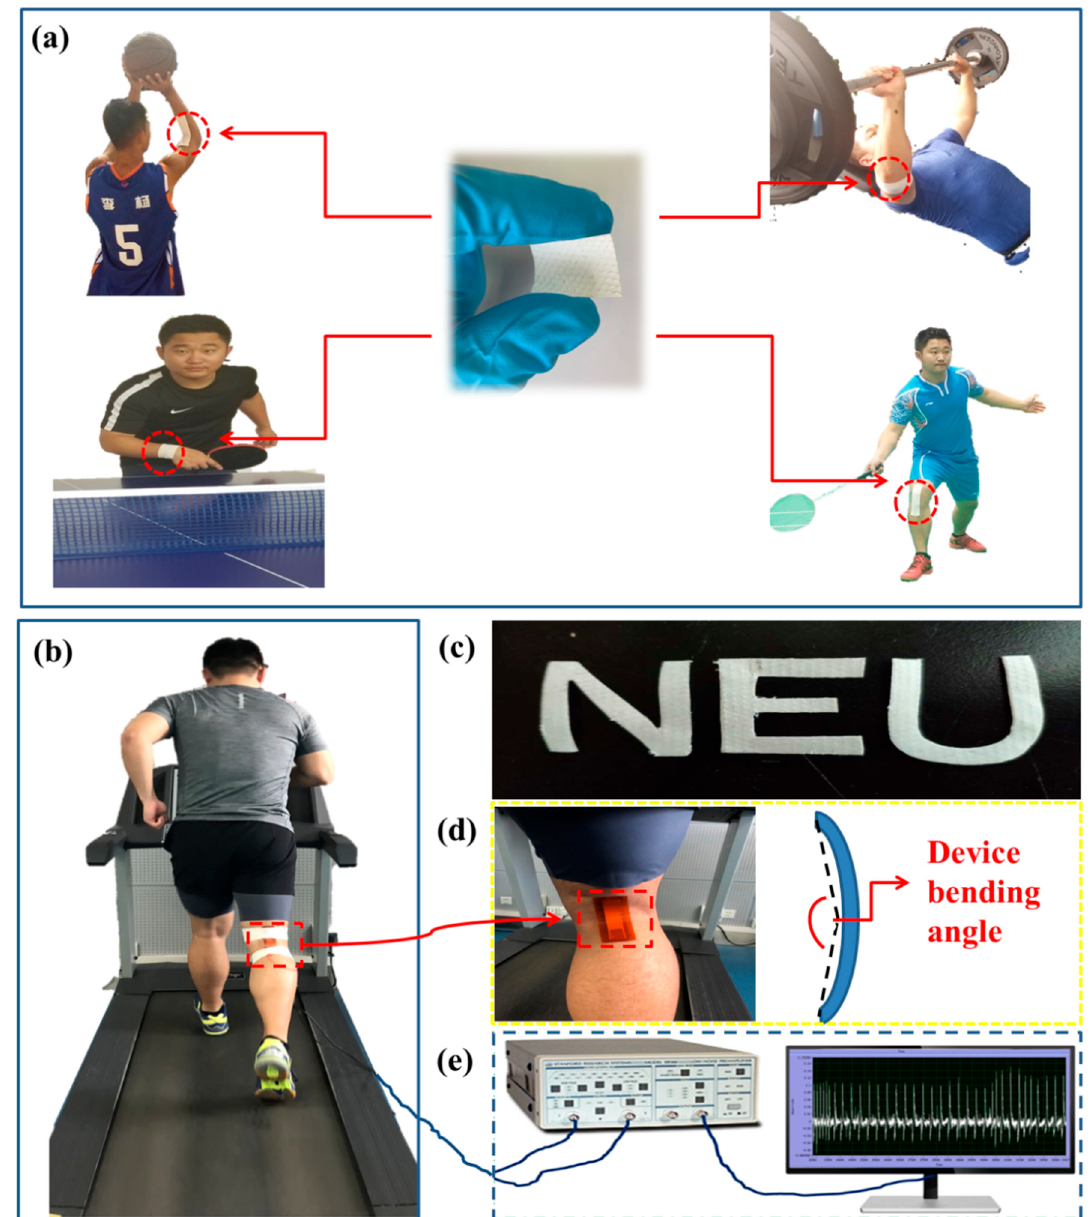
Figure 1. The experimental design of the self-powered piezoelectric-biosensing textiles. ( a ) The practical application. ( b – e ) Optical images and the experimental measurement setup.